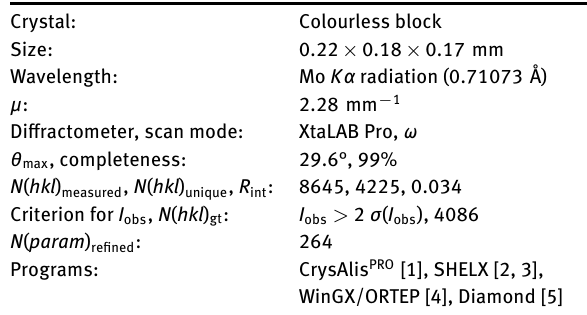
Table 1: Data collection and